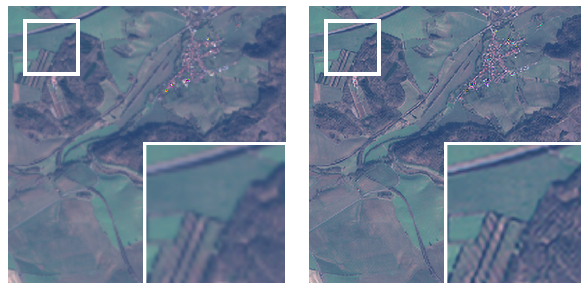
Figure 1. RGB composites with a spatial resolution of 10 m, up-sampled by a factor of two using bilinear interpolation (left) and our deep residual learning SISR approach